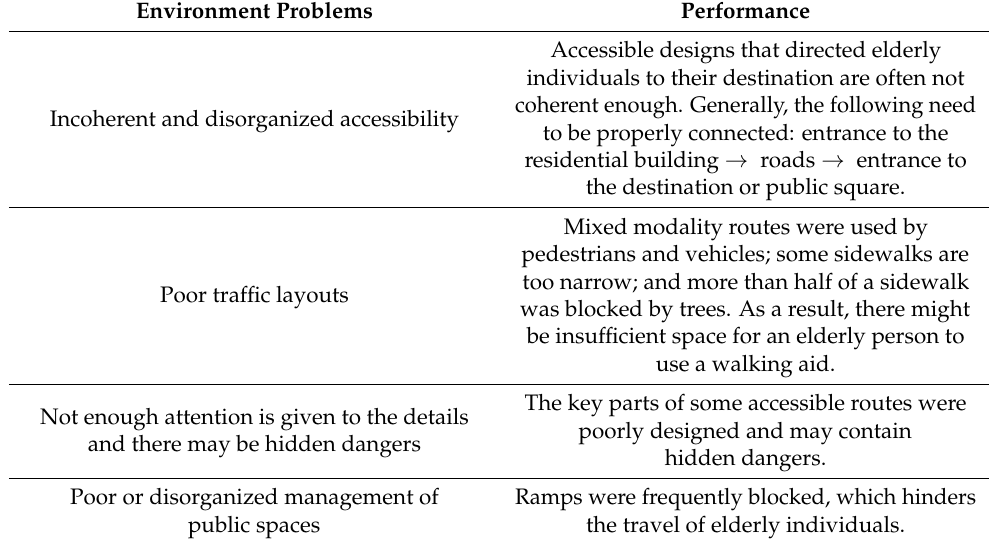
Table 3. The problems of barrier-free environments for elderly individuals during walking.